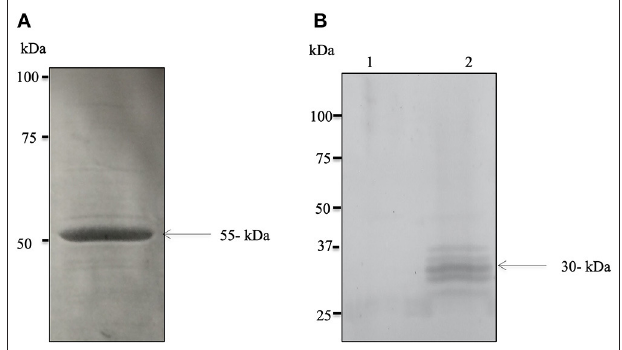
FIGURE 1 | Expression and molecular characterization of the native BdP0. (A) SDS–polyacrylamide gel electrophoresis of purified recombinant rBdP0 in E. coli . SDS-PAGE recombinant protein stained with Coomassie Blue at a concentration of ∼ 12% was utilized. The molecular weight of rBdP0 is 55 kDa. (B) Anti-rBdP0 serum produced in mice was used for Western blot of the lysates of non-infected (lane 1) and infected (lane 2) bovine erythrocytes. A distinct band at about 30 kDa was found in native